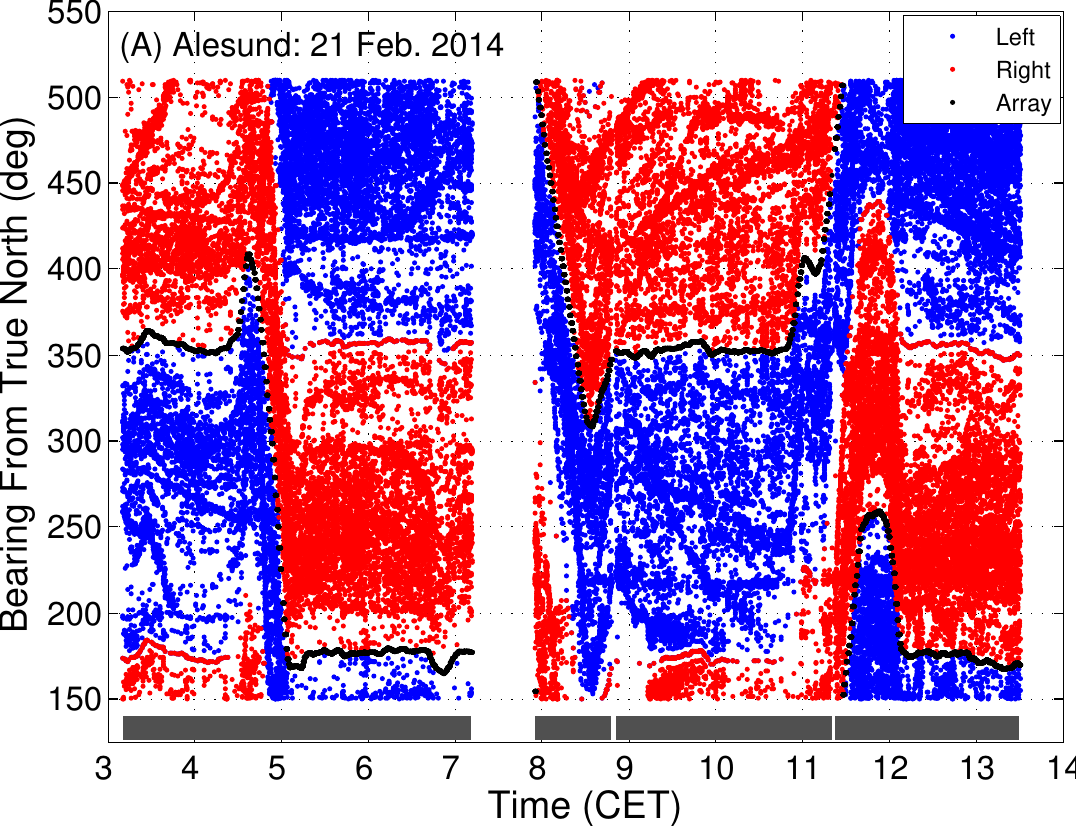
Figure 4. Bearing-time trajectories of acoustic signal detections spanning 360-degree horizontal azimuth about the POAWRS coherent hydrophone array from true north off the coast of Alesund, Norway on 21 February 2014 within the 10 to 200 Hz frequency range. This comprises a subset of detections for the day, since there are detections in other frequency sub-bands from 200 Hz to 4000 Hz not shown here. Blue and red dots correspond to left and right side bearings, respectively, for detections about the receiver array, before the line array’s left-right bearing ambiguity resolution. The black dots represent the array